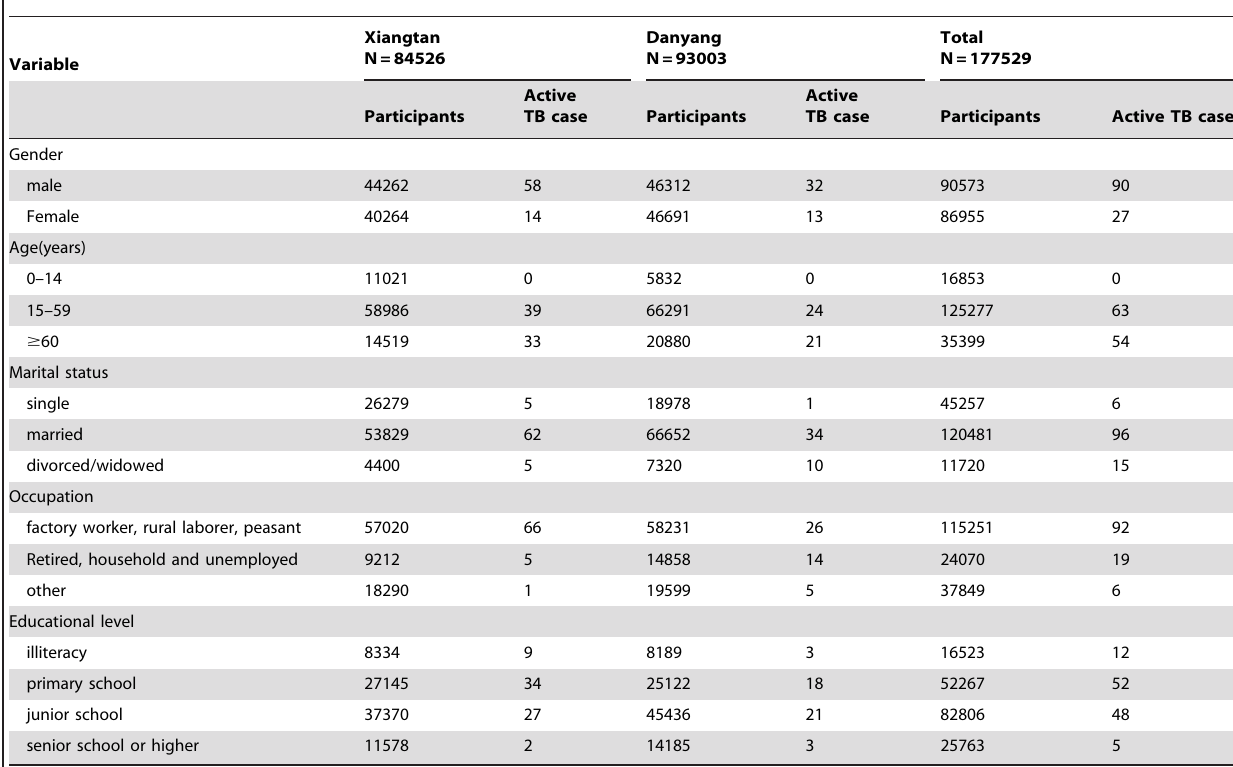
Table 1. Demographic Characteristics of Participants in the Study,